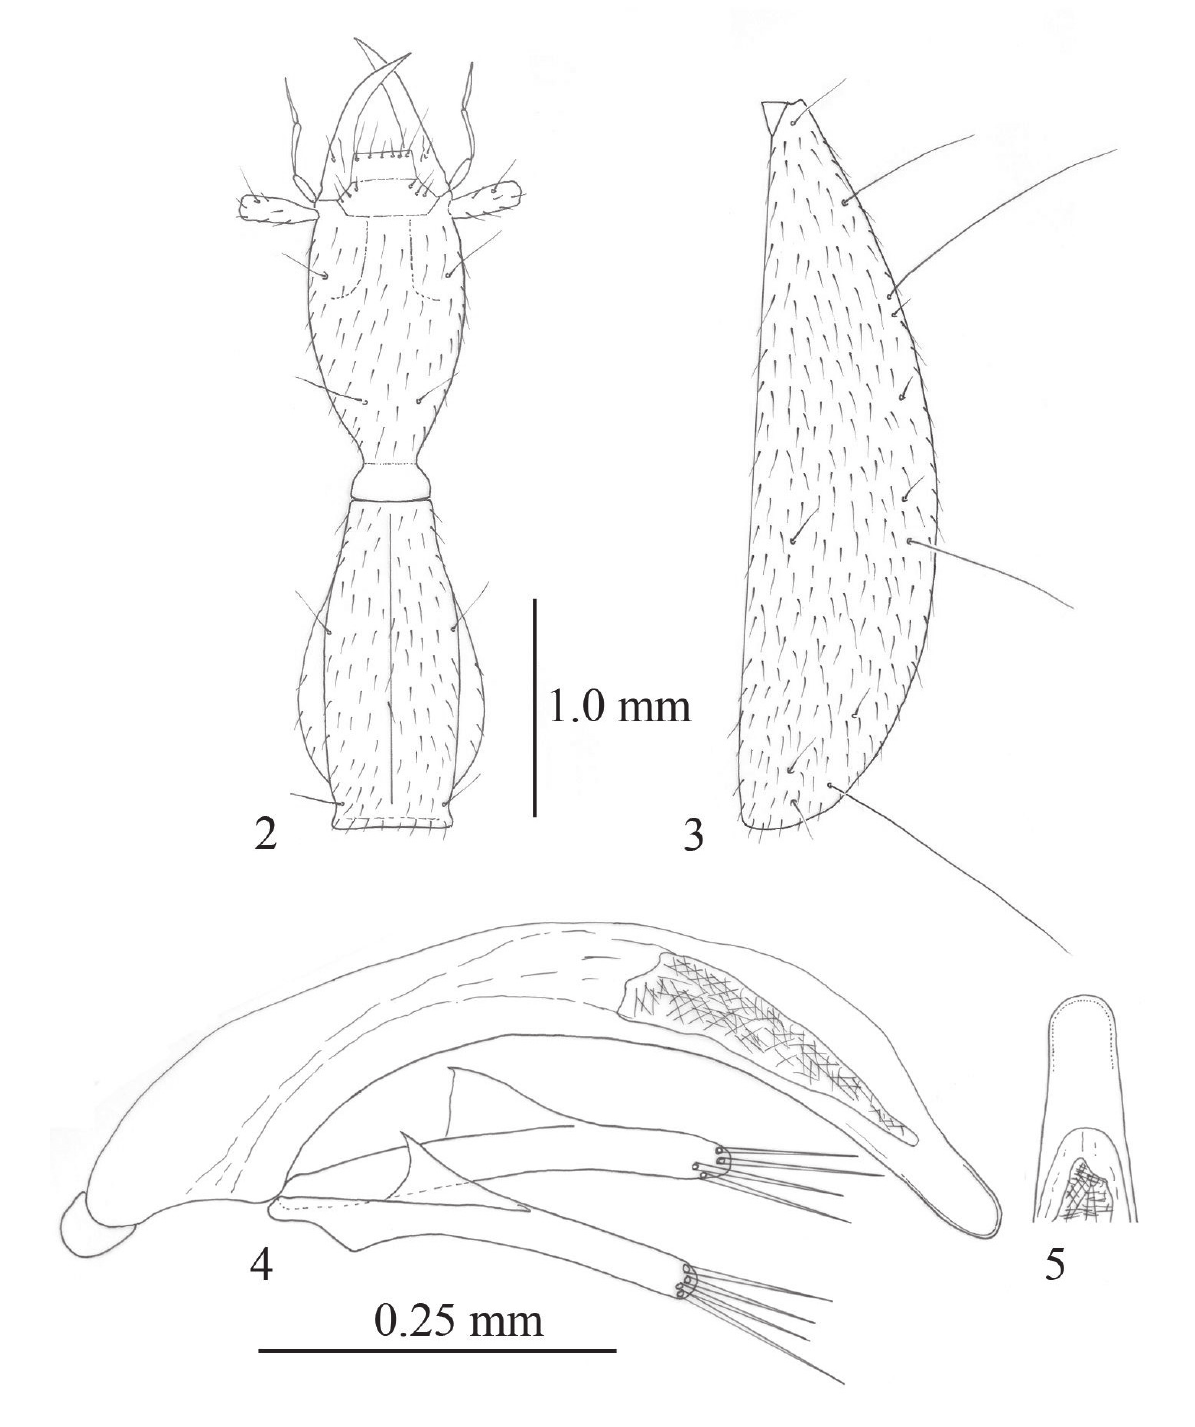
Figs 2-5 - Dongodytes (Dongodytodes) deharvengi , subgen. and sp. nov., holotype (2, head and prothorax; 3, right elytron; 4, aedea- gus, lateral view; 5, apical part of aedeagus, dorsal